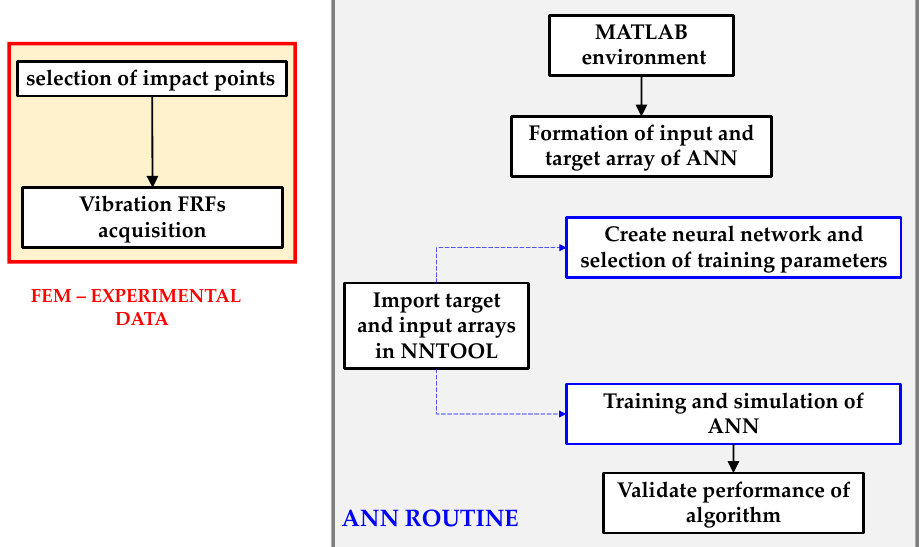
Figure 5. Block diagram of simulation processes—nested structure.